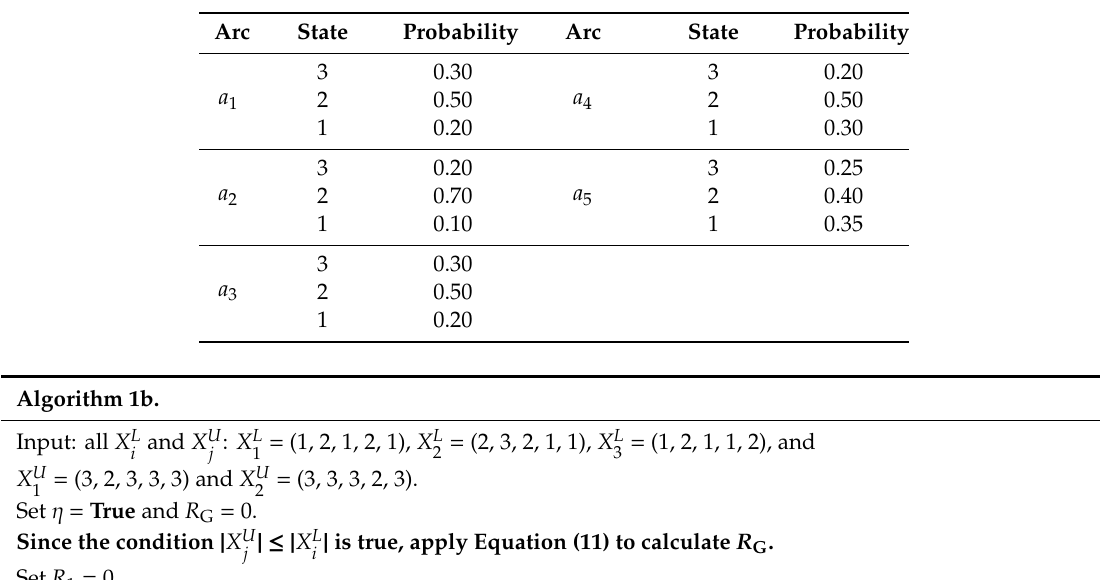
Table 1. Data of the small